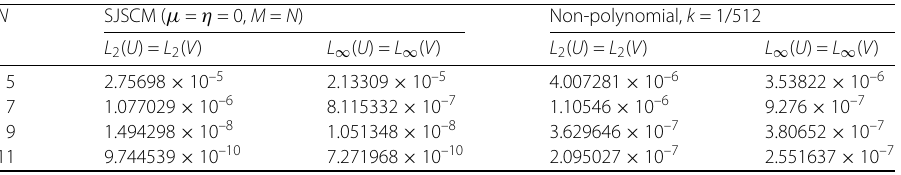
Table 10 L 2 and L ∞ error norms for u ( x , t ) = v ( x , t ) of Example 2 when 0 ≤ x ≤ 3, α 1 = α 2 = 0.05